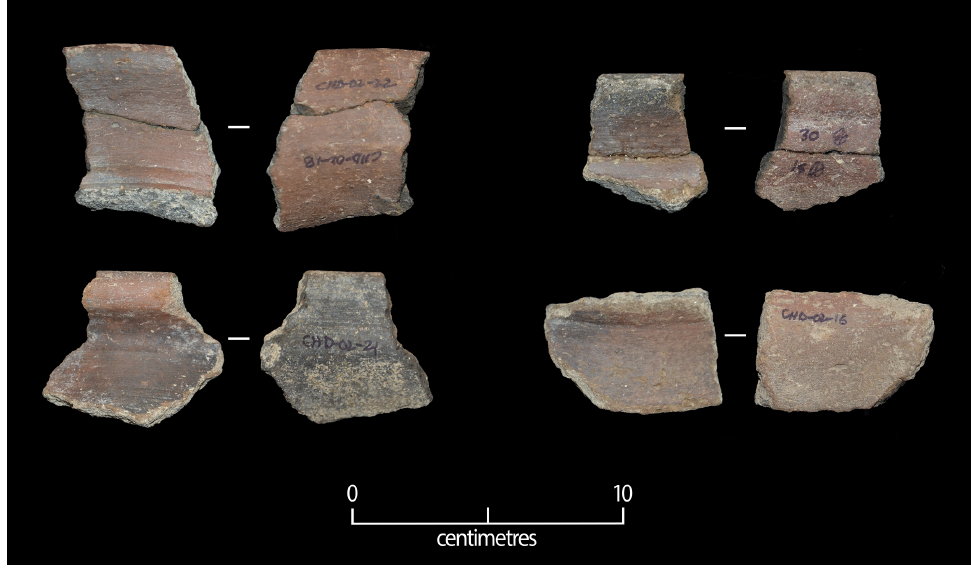
Figure 41: External and internal surfaces of Class 14 variant 6